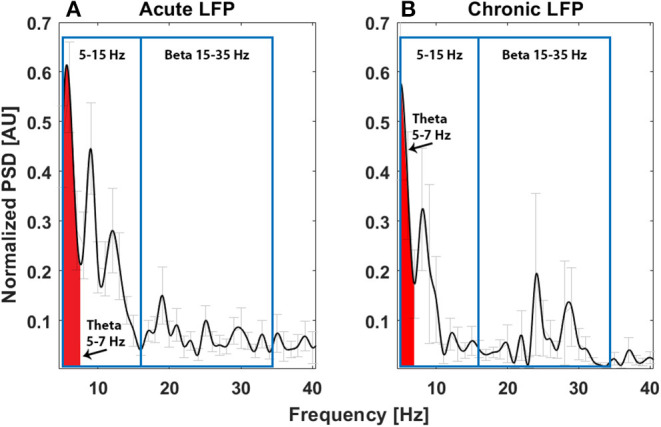
Average power spectrum in the acute (A, N = 11) and chronic (B, N = 6) experimental settings. The x-axis is the frequency (Hz), the y-axis is the normalized power spectral density (PSD, arbitrary unit), and light gray bars represent the standard error.